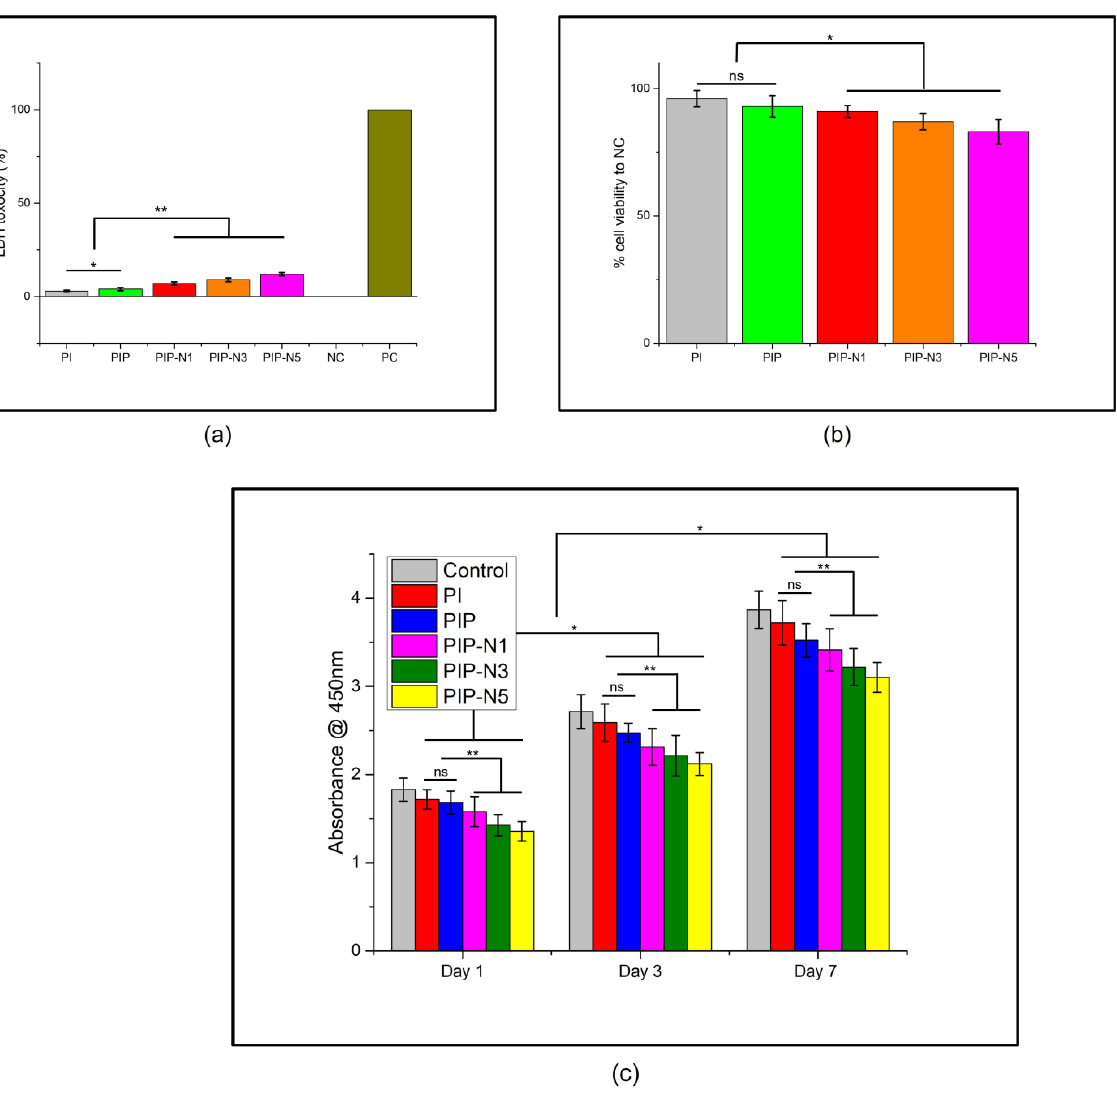
Figure 13. In vitro biocompatibility: ( a ) LDH release assay (n = 3; mean ± SD, * p < 0.002, ** p < 0.0001), ( b ) cell viability for toxicity (n = 3; mean ± SD, ns: p > 0.05, * p < 0.001), and ( c ) WST-1 cell proliferation assay (n = 3; mean ± SD, ns: p > 0.05, * p < 0.0001, ** p < 0.013).